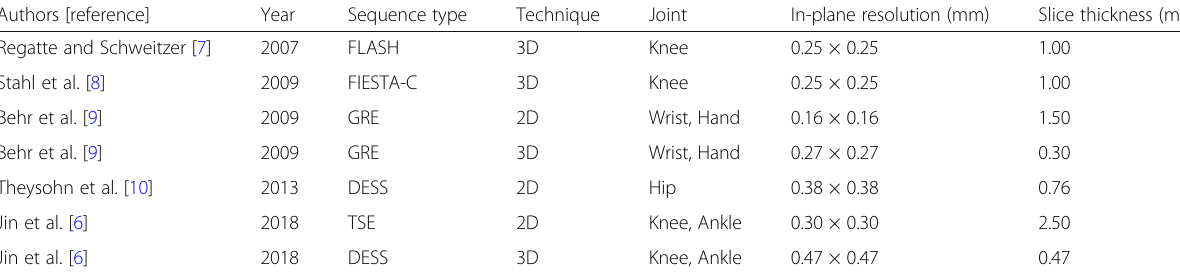
Table 1 Spatial resolution obtained at